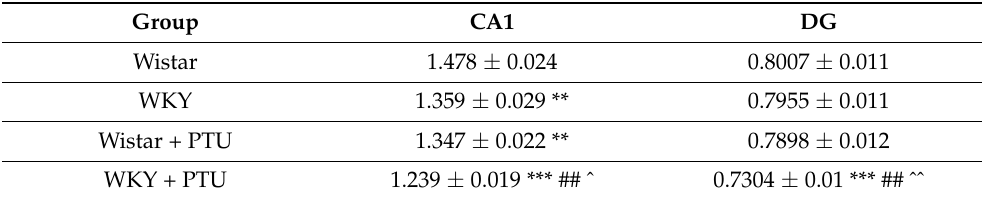
Table 3. Baseline-corrected paired-pulse ratio (PPR) in the CA1 and DG regions of the hippocampus. The results are expressed as the mean ± SEM. ** p < 0.01, *** p < 0.001 vs. the control group (Wistar rats) ## p < 0.01 vs. WKY group; ˆ p < 0.05, ˆˆ p < 0.01 vs. Wistar PTU group.